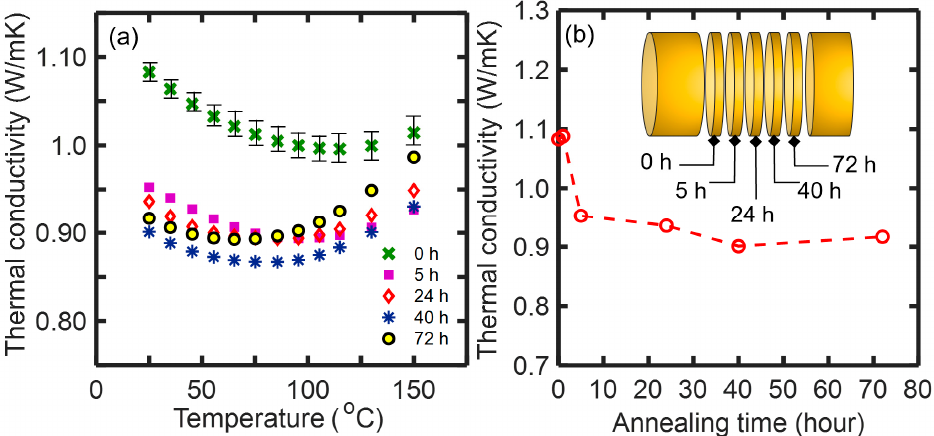
Figure 4. E ff ect of annealing at 230 ◦ C versus time on thermal conductivity of (Bi x Sb 1 − x ) 2 Te 3 -5% Figure 4. Effect of annealing at 230 °C versus time on thermal conductivity of (Bi x Sb 1 − x ) 2 Te 3 -5% glass glass nanocomposites ( a ) from 25 ◦ C to 150 ◦ C, and ( b ) at room temperature. The inset of ( b ) shows nanocomposites ( a ) from 25 °C to 150 °C, and ( b ) at room temperature. The inset of ( b ) shows a a schematic picture of the diced samples for schematic picture of the diced samples for annealing.